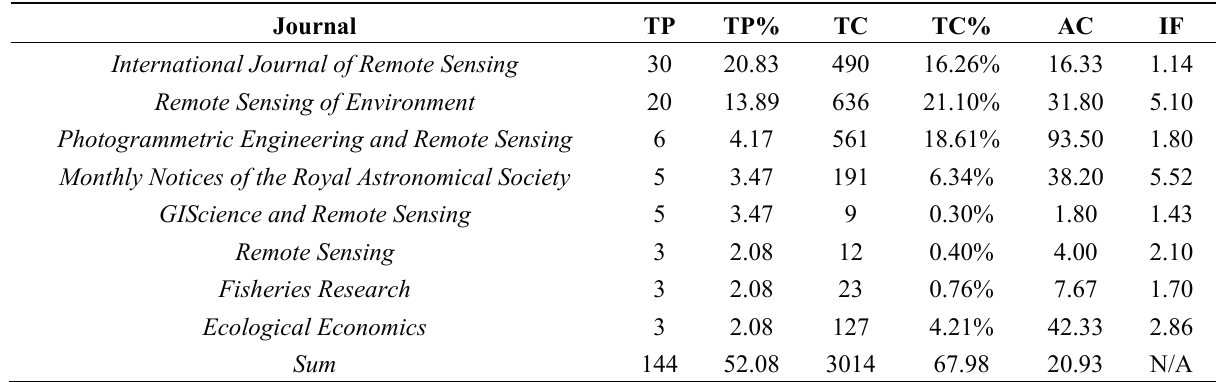
Table 2. The top eight most active journals publishing research based on DMSP/OLS